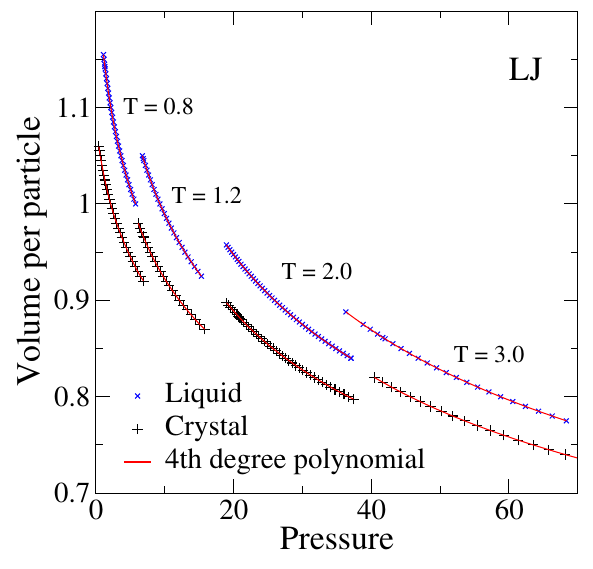
Figure 5: Volumes along the isotherms T = { 0.8,1.2,2.0,3.0 } of the LJ system in the solid and liquid state. 4th degree polynomial fits (lines) are subsequently used to compute the difference in chemical potential between solid and liquid ∆ µ . are given in Table